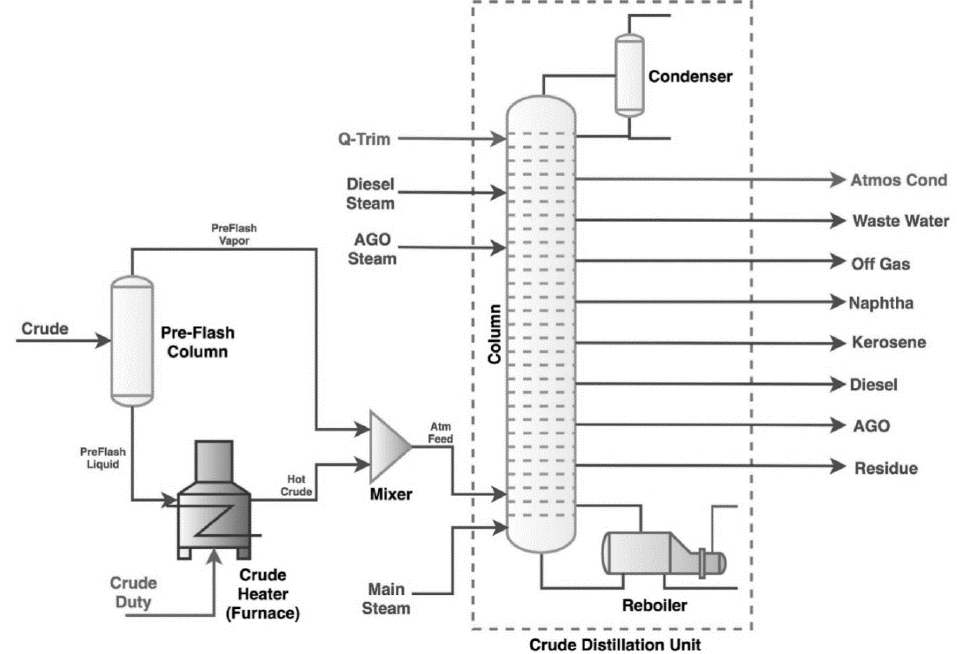
Figure 2. Crude distillation unit process flow diagram. Table 1. Specifications of Pakistani Crudes: Bobi, Kunnar and Zamzama.